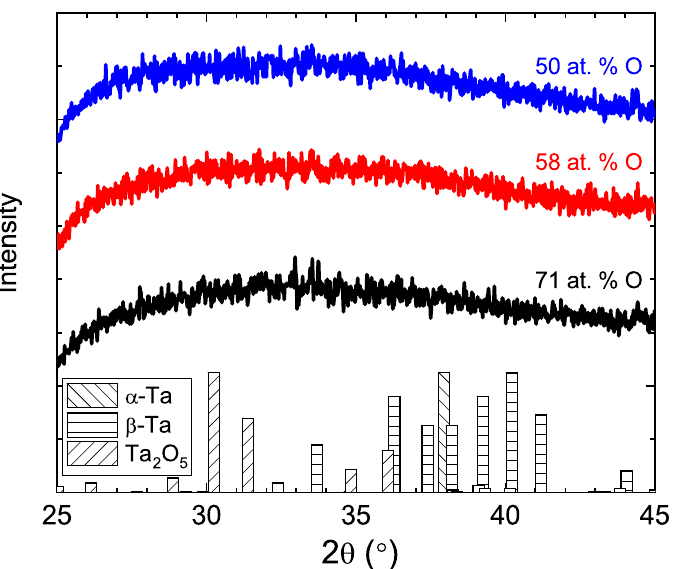
Figure 3. X-ray diffraction patterns for representative films with different O contents as indicated. Vertical bars denote expected peak positions and intensities for α -Ta, β -Ta, and Ta 2 O 5 powder diffraction. The broad, featureless patterns indicate that the films are X-ray amorphous. The patterns are vertically offset for clarity.